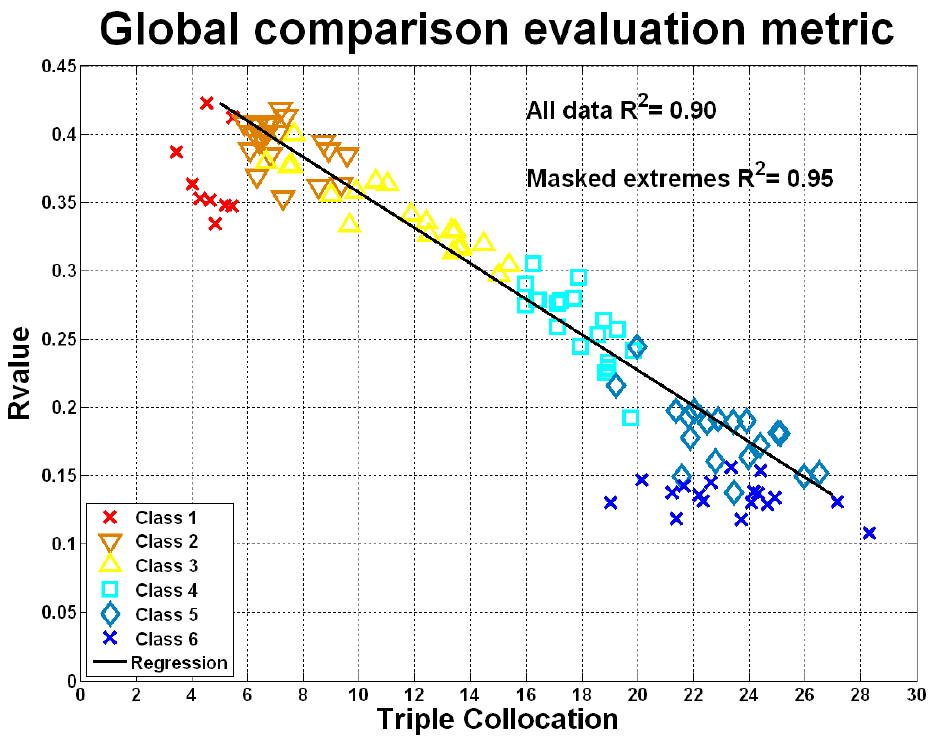
Fig. 7. Comparison of soil moisture anomaly skill according to the TC and the R value techniques for AMSR-E night-time (descending) retrievals. The vegetation classes refer to ranges of canopy optical depth defined in Table 1. Masked extremes refer to the vegetation classes 1 and 6 (Table 1 and Fig.